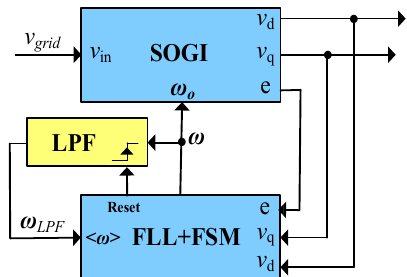
Figure 12. Block diagram structure of the SOGI-FLL-FSM including a low-pass filter (LPF) for tracking the grid frequency.